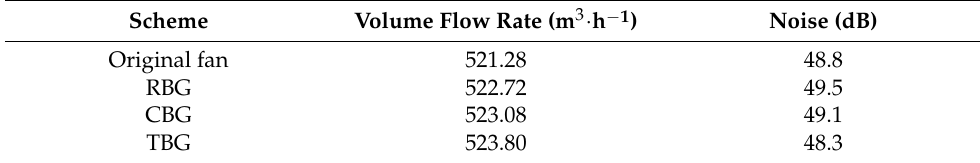
Table 3. Results of Noise and Volume Flow Rate.